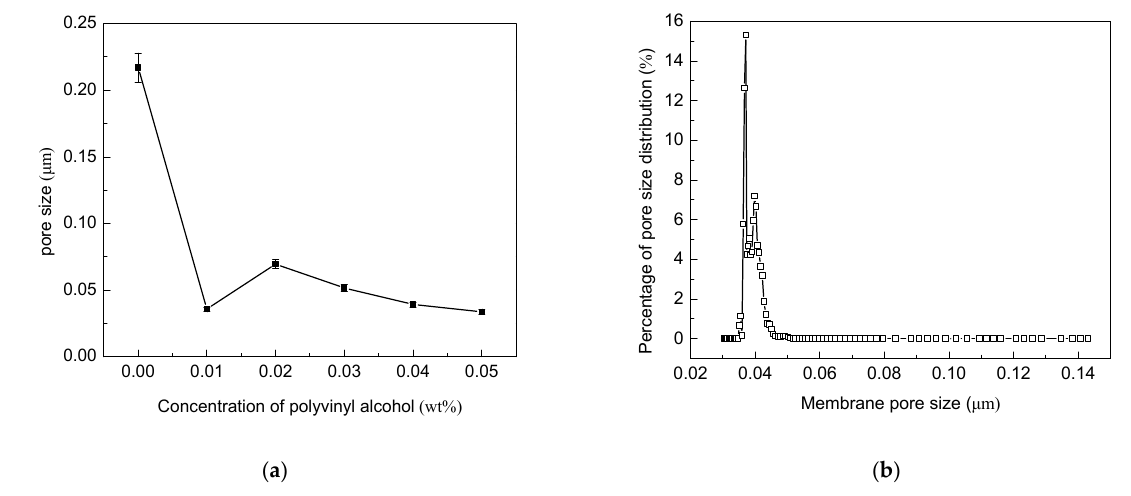
Figure 5. Pore size analysis of MWCNTs/PVDF conductive membrane: ( a ) Change of average pore diameter of conductive membrane; ( b ) Pore size distribution of conductive membrane (PVA concentration was 0.05 wt%).